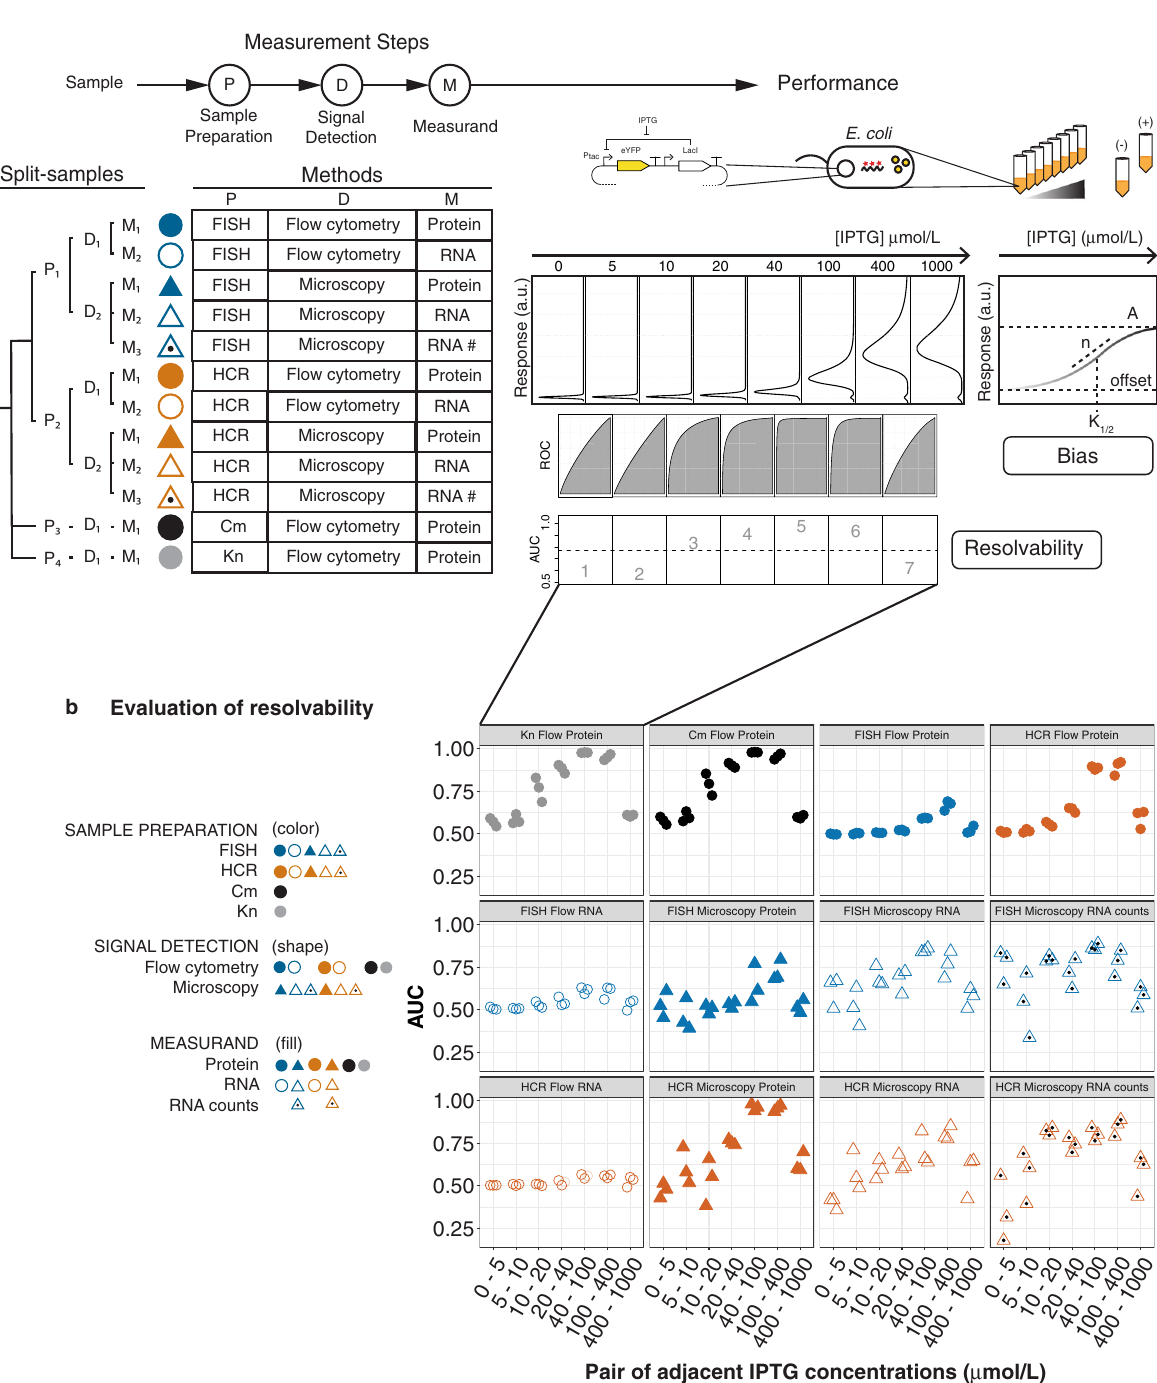
Fig. 1 Experiment design and evaluation of resolvability. a In this study, each cell culture is divided (split) to perform multiple methods in parallel for measuring the same underlying system of cellular sense and response. Eight cultures were measured over a range of induction with IPTG. Methods include various combinations of sample preparation, signal detection, and choice of measurand. Resolvability is quantitatively assessed using Area Under the receiver operator characteristic Curve (AUC) calculated across a range of IPTG concentrations. Relative bias is assessed by modeling cellular response using measurements from each method and comparing the resulting parameters. b Evaluation of resolvability with AUC pro fi les for all 12 methods. In each panel, the plotted symbols show the AUC for pairs of adjacent IPTG concentrations as indicated on the x